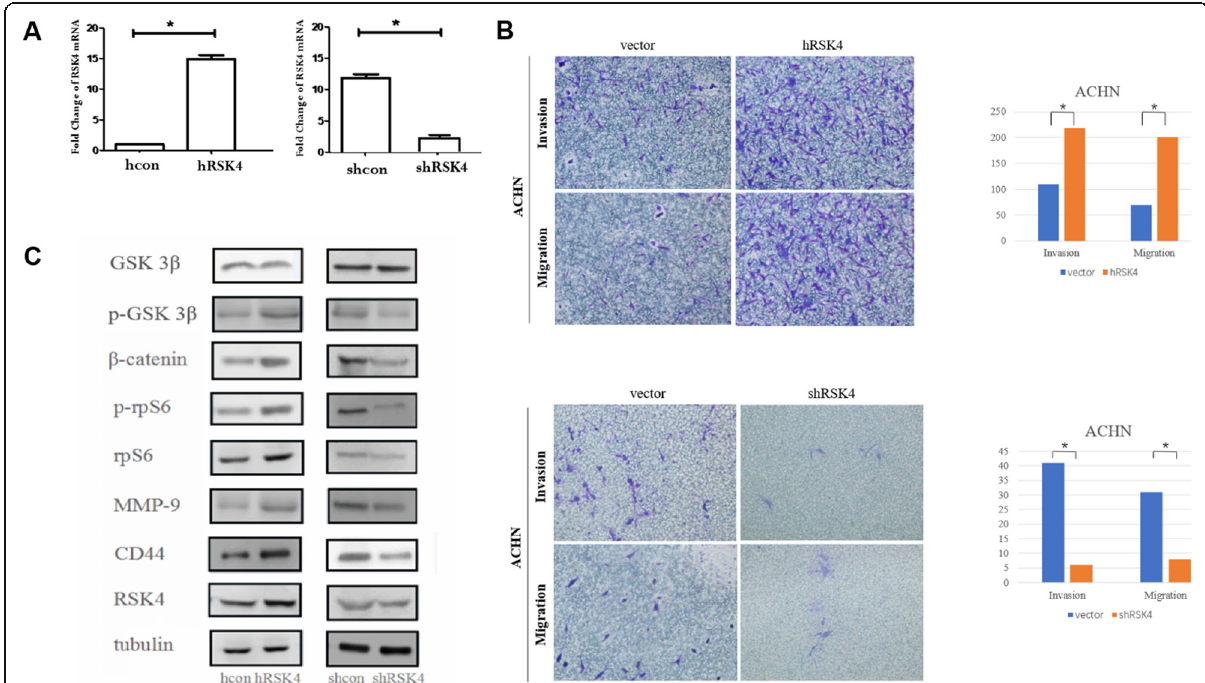
Fig. 3 RSK4 promotes the invasive and metastatic activities of RCC cells. a qRT-PCR showed increased levels of RSK4 mRNA and protein (* P < 0.05). b RSK4-overexpressing ACHN cells showed elevated numbers of invasive and metastatic cells compared with the vector control cells (above, * P < 0.05 vs vector). When RSK4 was downregulated by shRNA, the number of invasive and metastatic cells was reduced (below, * P < 0.05 vs vector). c RSK4-overexpressing ACHN cells showed increased levels of CD44 and MMP-9; however, RSK4-suppressed cells had decreased levels of CD44 and MMP-9. Tubulin was used as a loading control. Moreover, RSK4-overexpressing ACHN cells showed increased levels of pGSK-3 β Ser9 , β -catenin, rps6 and p-rps6, whereas in the opposite was observed for the RSK4-suppressed